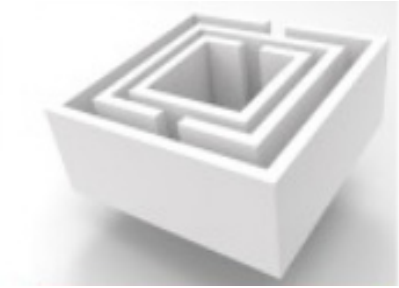
Figure 25. The diagram of the proposed structure [82].